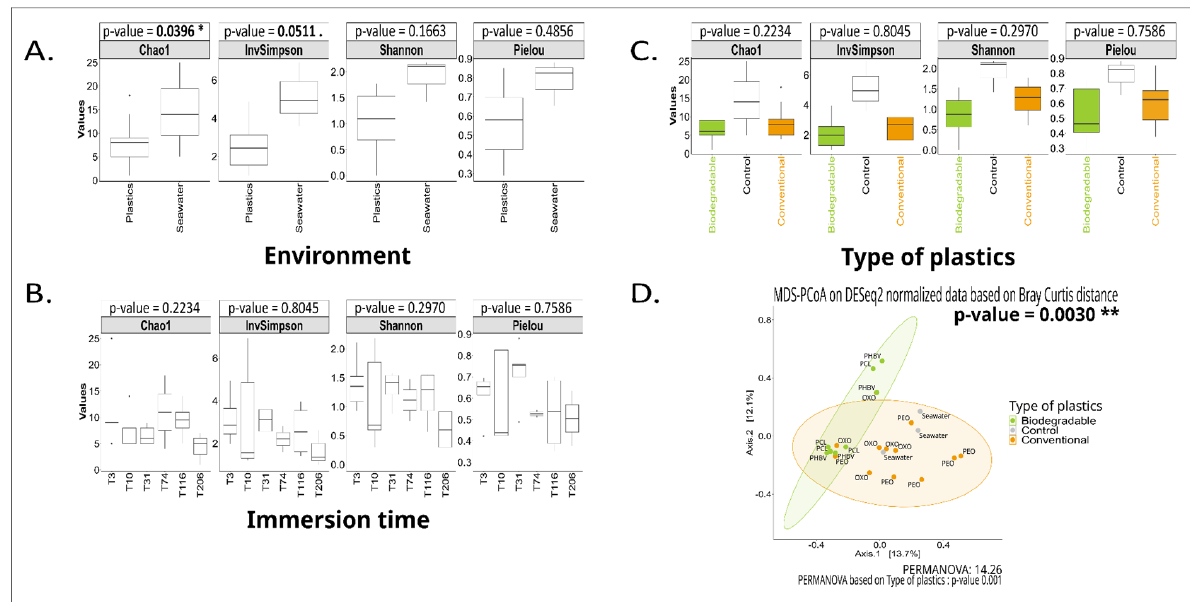
Figure 8. Significance of alpha diversity indices for the variable ( A ) “Environment”, ( B ) “Immersion time” (days), and ( C ) “Type of plastics”. ( D ) The PCoA demonstrates the relationship between the similarity in fungal community composition and the variable “Type of plastics”. “*” and “**” represent a significant, and a highly significant influence of the evaluated factor, respectively. The PCoA was generated using Bray–Curtis dissimilarity as the distance measure, with each point representing a sample. Ellipses connect groups of samples that were subjected to the same conditions.